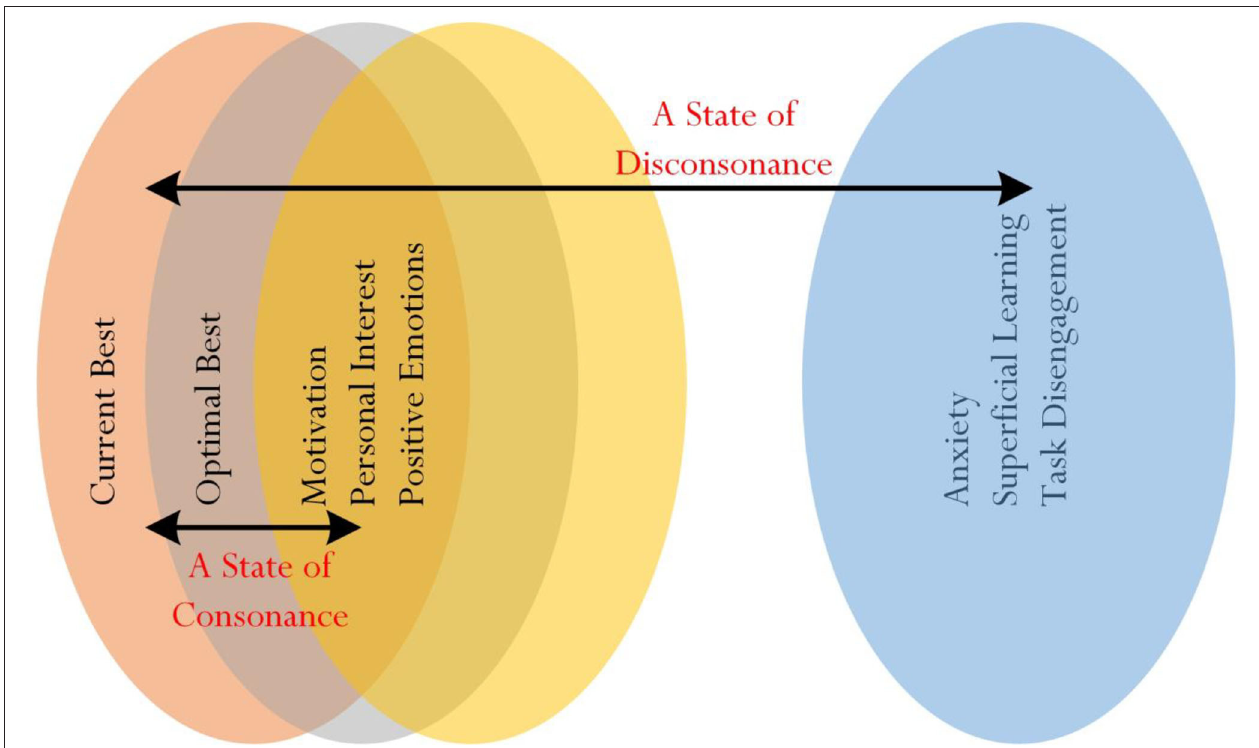
FIGURE 4 | A State of Consonance of Best Practice. Source: Phan and Ngu